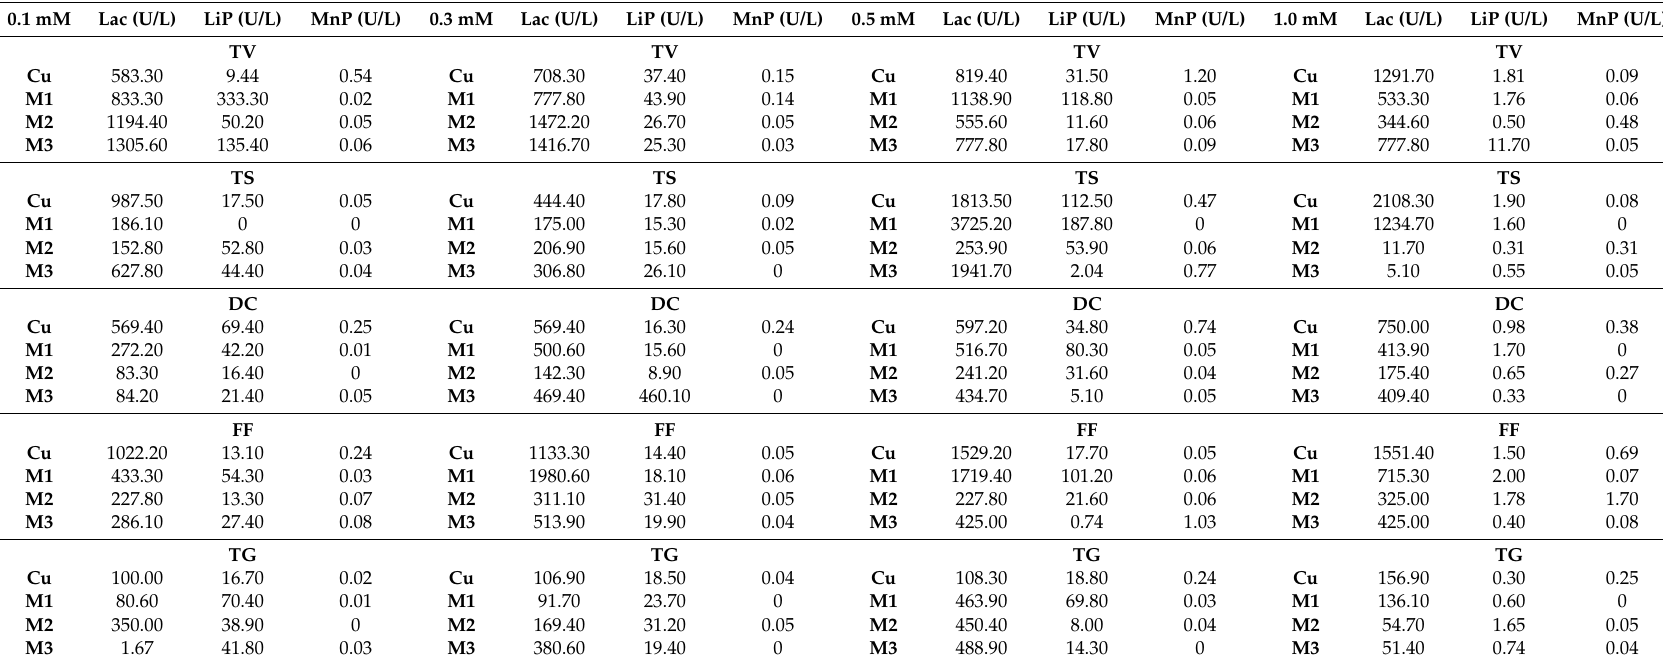
Table 3. Enzyme activities of Lac, LiP and MnP using different concentrations (0.1, 0.3, 0.5 and 1.0 mM) of copper sulfate and complexes M1, M2 and M3 for the